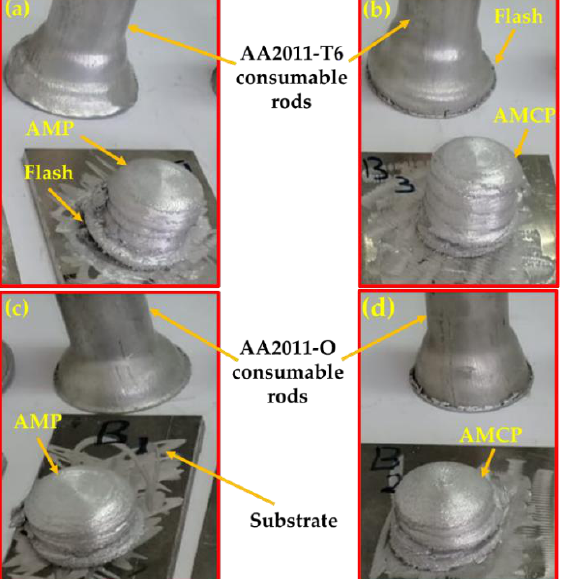
Figure 6. Photographs of the additive manufacturing materials: ( a ) AMP and ( b ) AMC using AA2011-T6 and ( c ) AMP and ( d ) AMC using AA2011-O deposited at an 800 rpm rotation speed and a 5 mm/min feed rate.